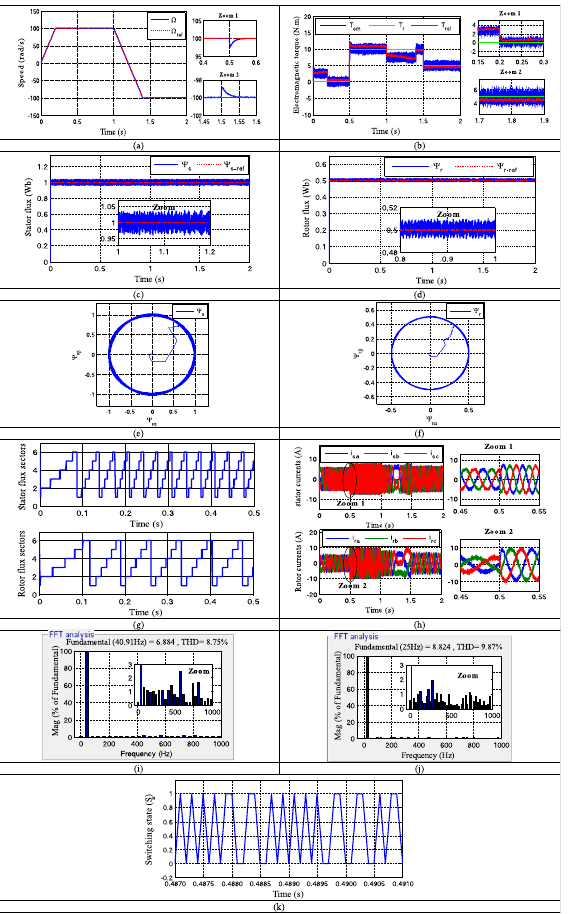
Fig. 8 Simulation results of DTC using 3LVSIs: ( a ) rotation speed ( b ) electromagnetic torque ( c ) Stator flux ( d ) Rotor flux ( e ) Stator flux trajectory ( f ) Rotor flux trajectory ( g ) Stator and rotor flux sectors ( h ) Stator and rotor currents ( i ) FFT analysis of stator current i sa ( j ) FFT analysis of rotor current i ra ( k ) Switching